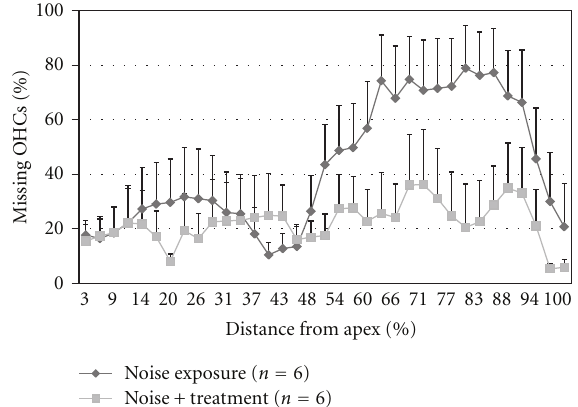
Figure 2: A cytocochleogram representing mean percentage of missing OHCs at the measured percent distance from the cochlear apex in the noise exposure and the noise/treatment groups. Reduced OHC loss was found in the noise/treatment group compared to the noise exposure group, especially at the 55–100% distance from cochlear apex. There is a significant di ff erence between these two groups in average OHC loss in the cochleae ( P < 0 . 001, error bars represent standard error of the means. Number of cochleae = 6 in each